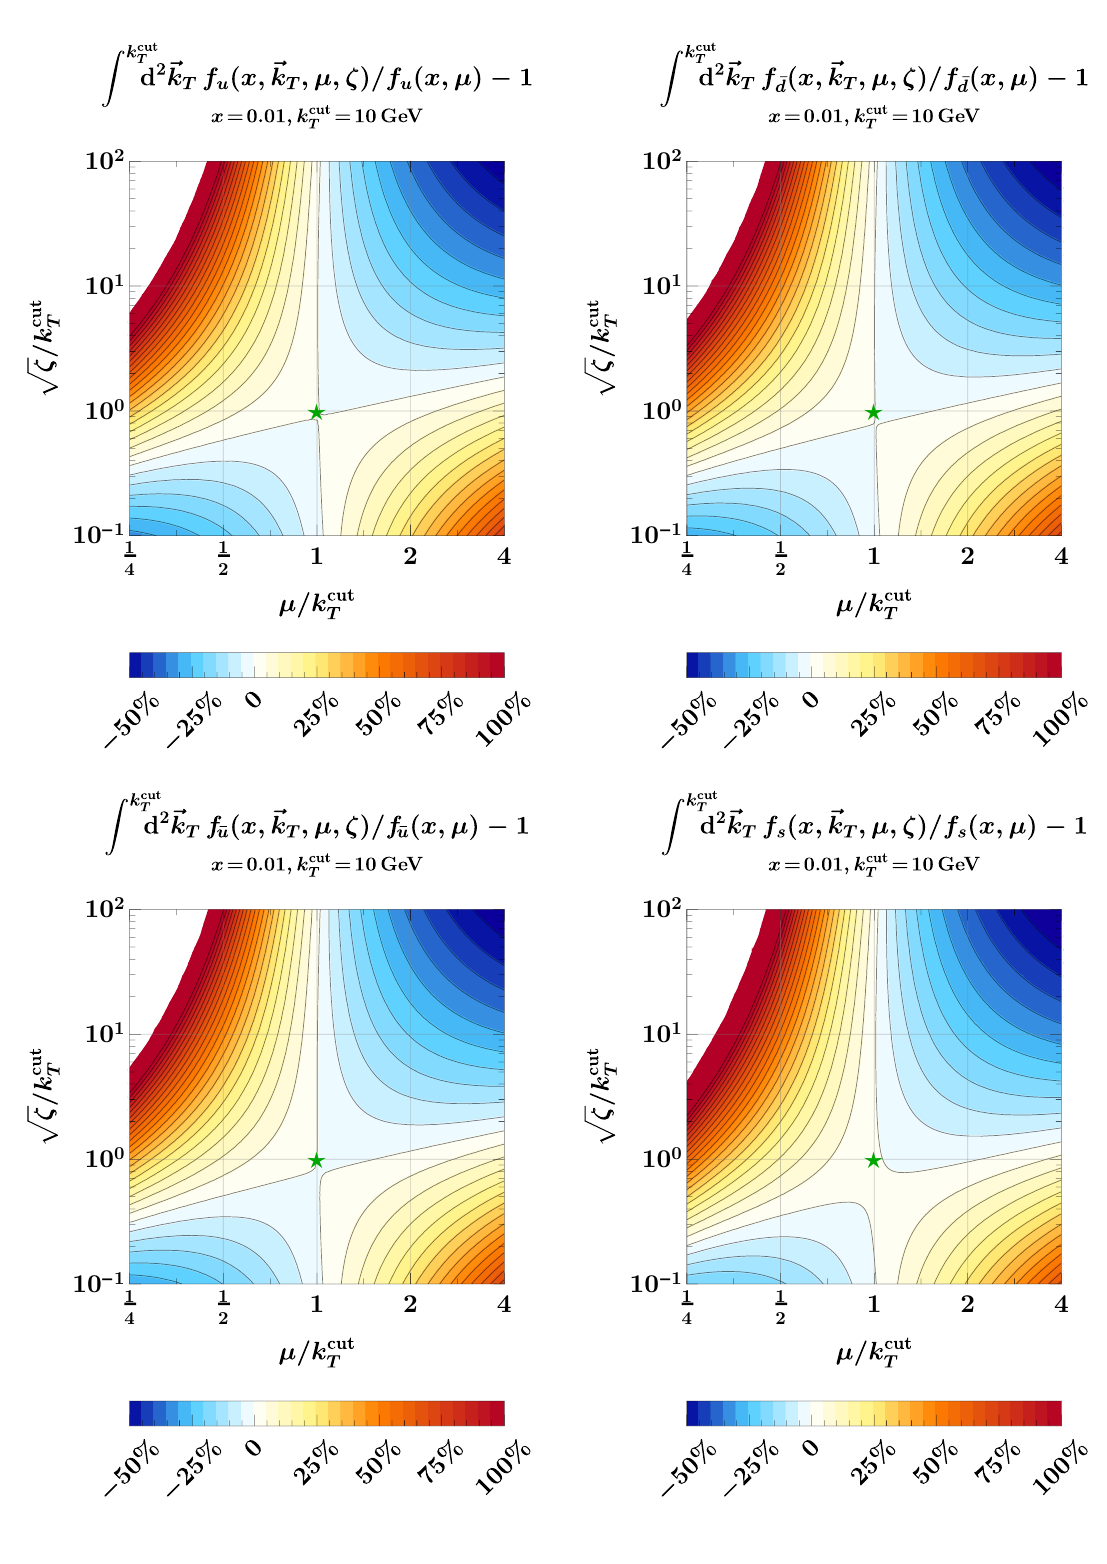
Figure 14 . Same as figure 8, for i = u, ¯ d, ¯ u, s